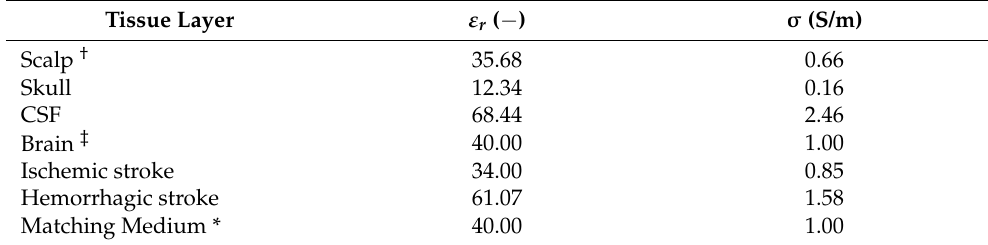
Table 1. Dielectric properties of the domain in the human head modes at 1 GHz [21].